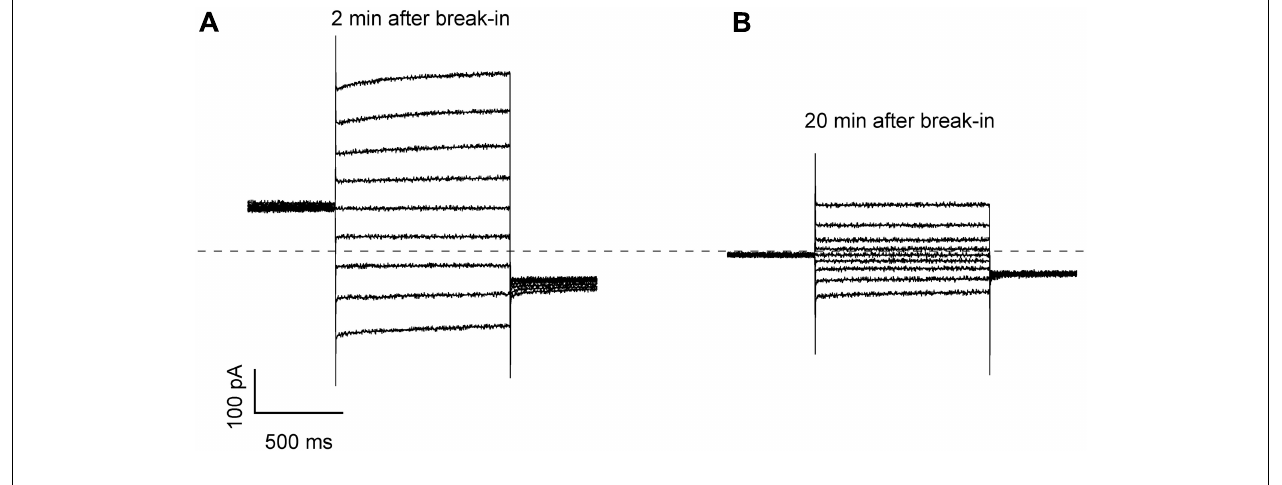
and tail voltages were 0 and − 50 mV, respectively.The vacuole had a capacitance of 34 pF and derived from an Arabidopsis wild-type